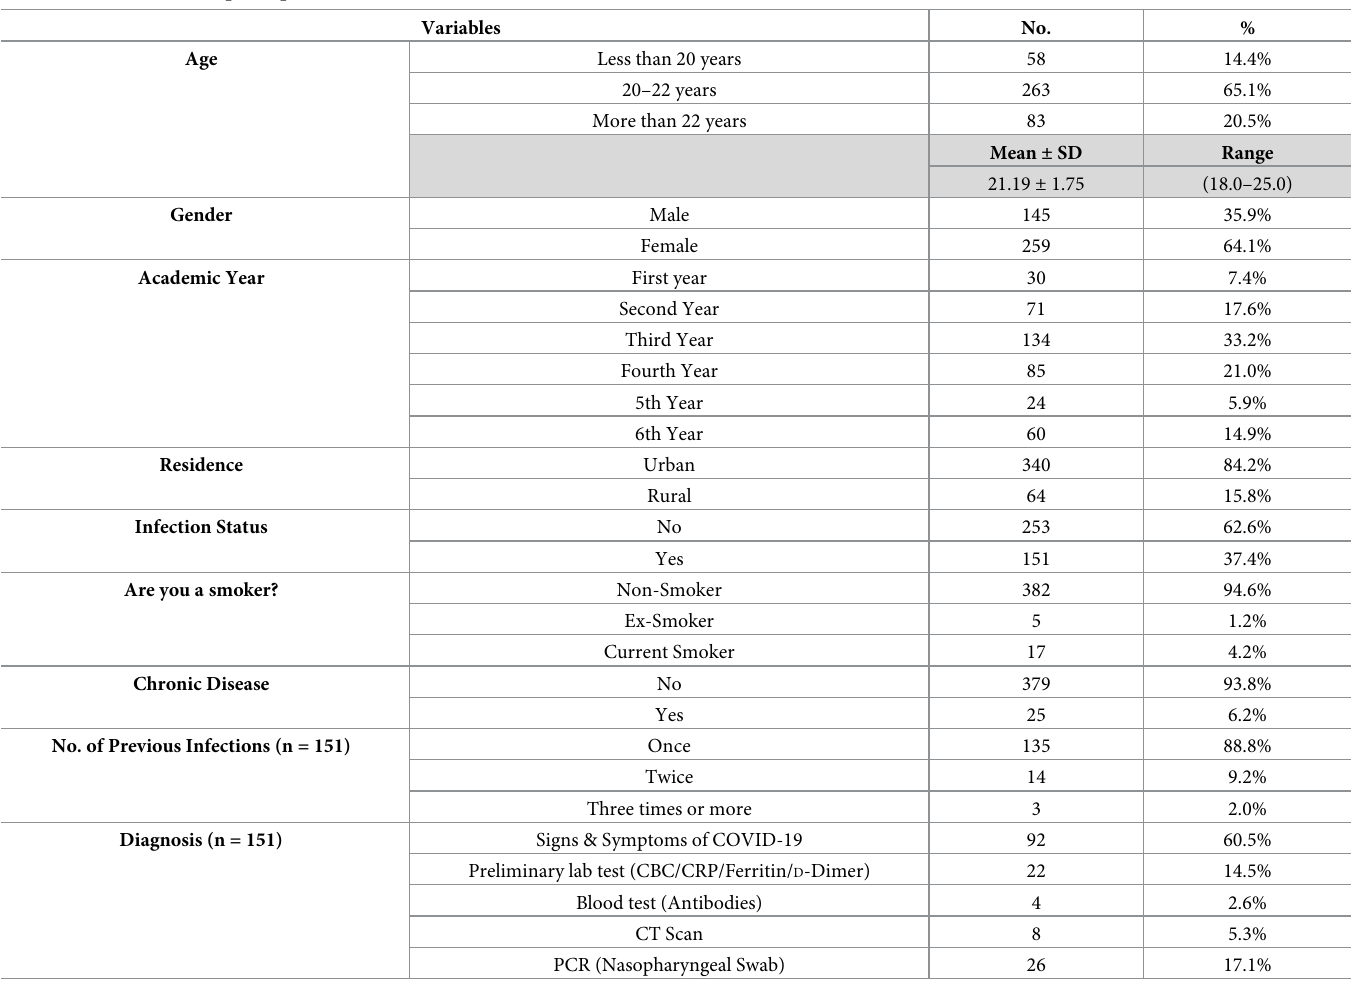
Table 1. Characteristics of